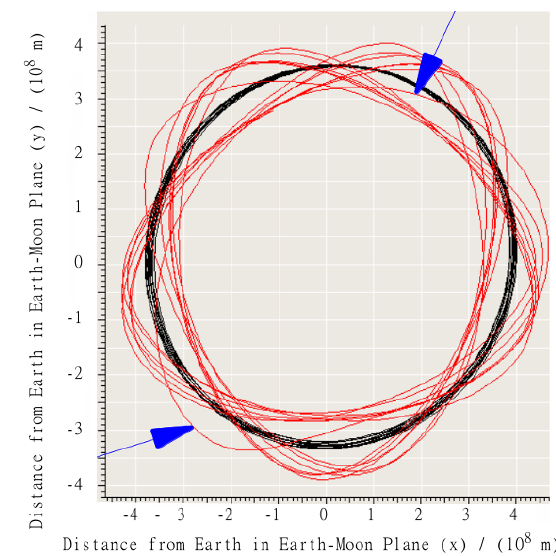
Figure 6. The 2:3:5 Resonance. The black line (circular trajectory) represents the lunar orbit, and the red line (irregular trajectory) the DRO. This trajectory was stable for only approximately 1 year; the final pass is identified with the blue arrows showing the divergence of the trajectory from its initially-settled path. The vehicle had a close lunar encounter and was ejected from the Earth–Moon system shortly after this data set was captured.